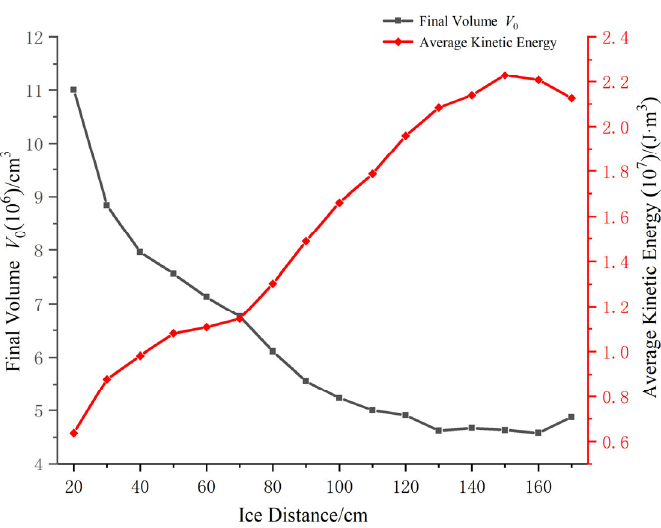
Figure 12. Relationship between ice distance, final volume, and average kinetic energy.